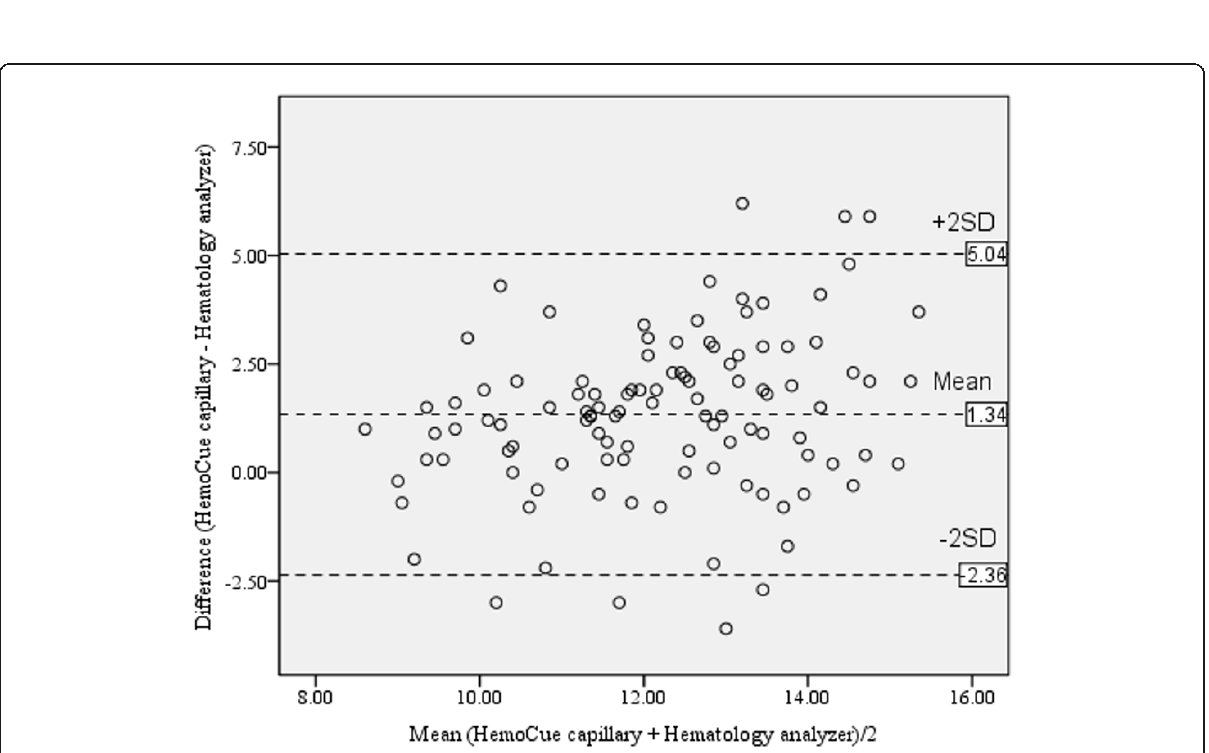
Figure 2 Bland and Altman plot for hemoglobin level by using HemoCue ® capillary sample versus automated hematology analyzer (g/dl)